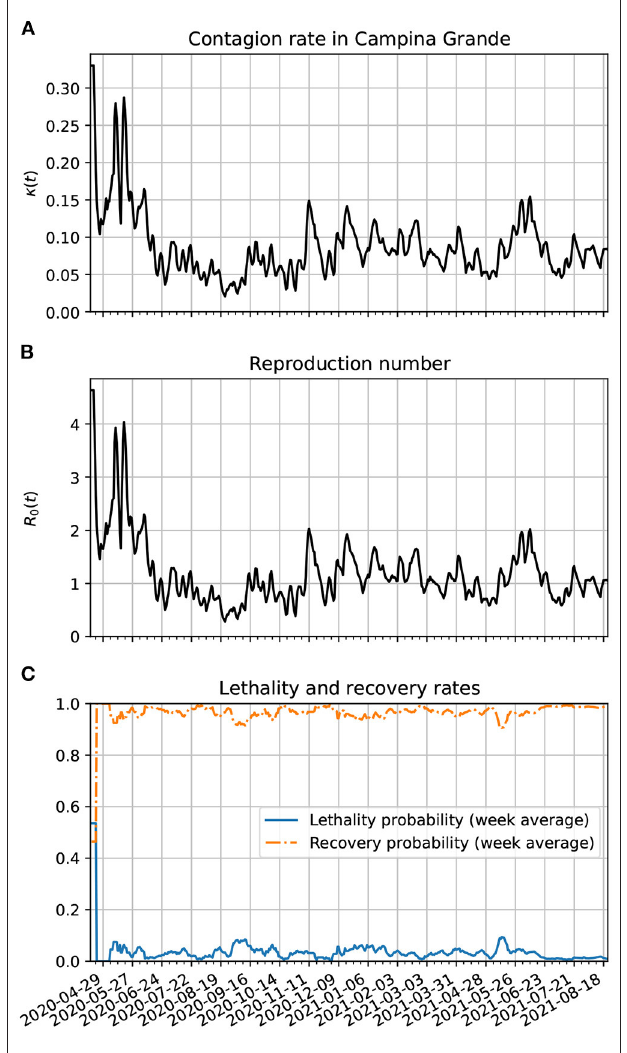
FIGURE 9 | Parameter estimation of the theoretical model based on epidemiological data from Campina Grande. (A) Time variation of the contagion rate. This function was obtained from the statistically estimated active cases described in Section 3.3 and the method of Section 3.4.2. The initial cutoff value of κ ( t ) is 0.3. (B) Corresponding dynamic reproduction number evolution. (C) Estimates for the lethality and recovery rates based on Section